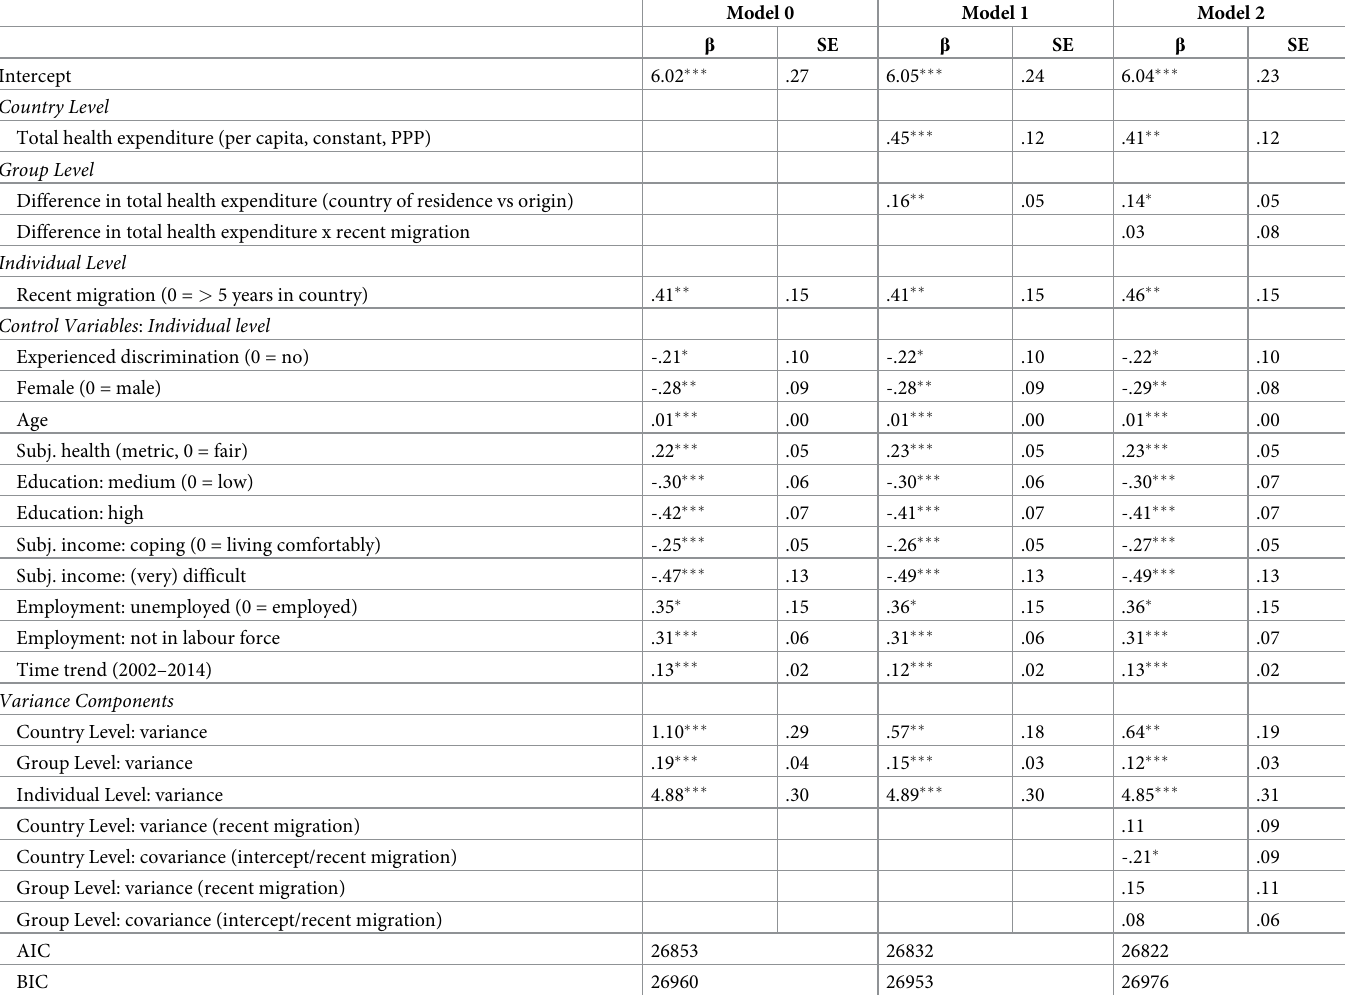
Table 1. Effect of total health expenditure on healthcare